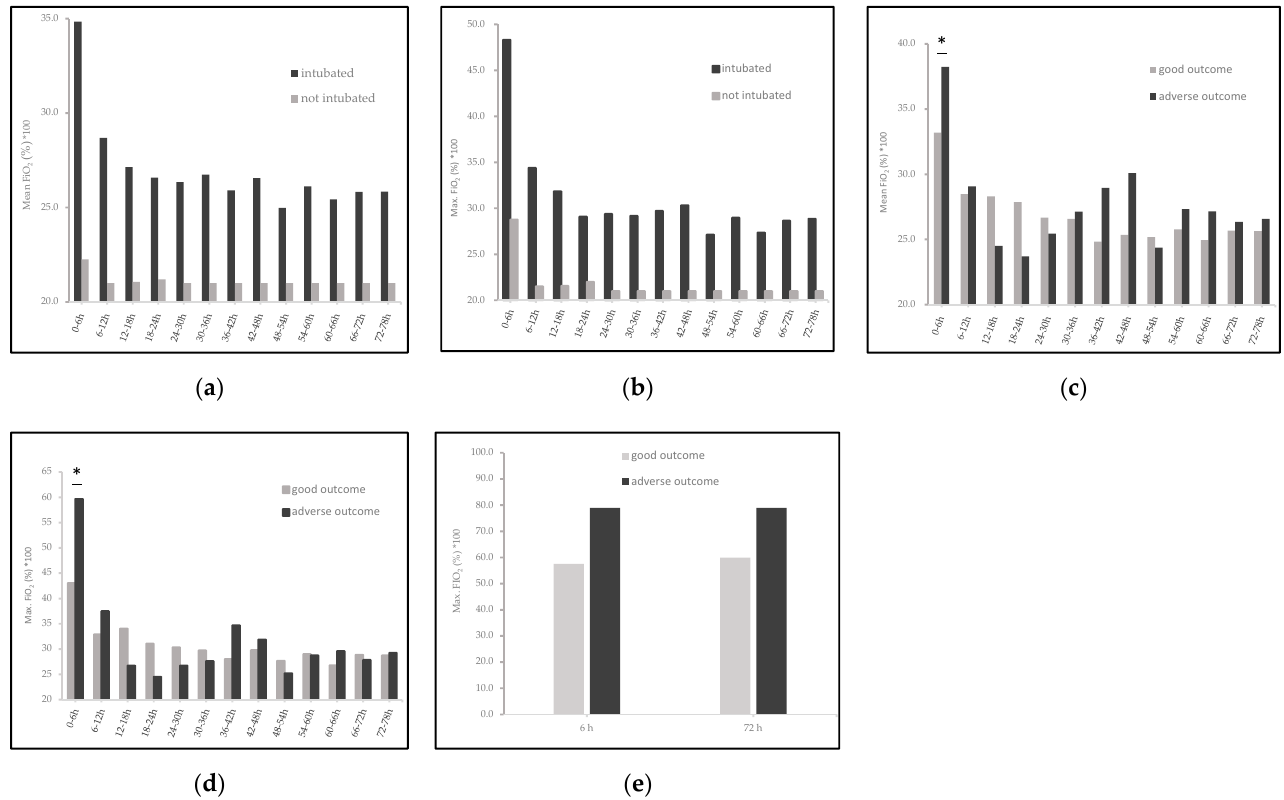
Figure 3. Significant differences of average and highest FiO 2 (mean and maximum FiO 2 ) with outcome and ventilation status. Maximum FiO 2 over the first 6 and 72 HOL was directly associated with adverse outcomes in the whole study group ( e ), p < 0.05. Mechanically ventilated neonates had significantly higher needs of inspired oxygen, mean ( a ) and maximum ( b ) FiO 2 , during the whole period of TH, p < 0.05. Mean ( c ) and maximum ( d ) FiO 2 were in total not significantly associated with adverse outcomes in the group of intubated newborns after the initiation of TH. Values are represented as mean ( ± SD), * p < 0.05.